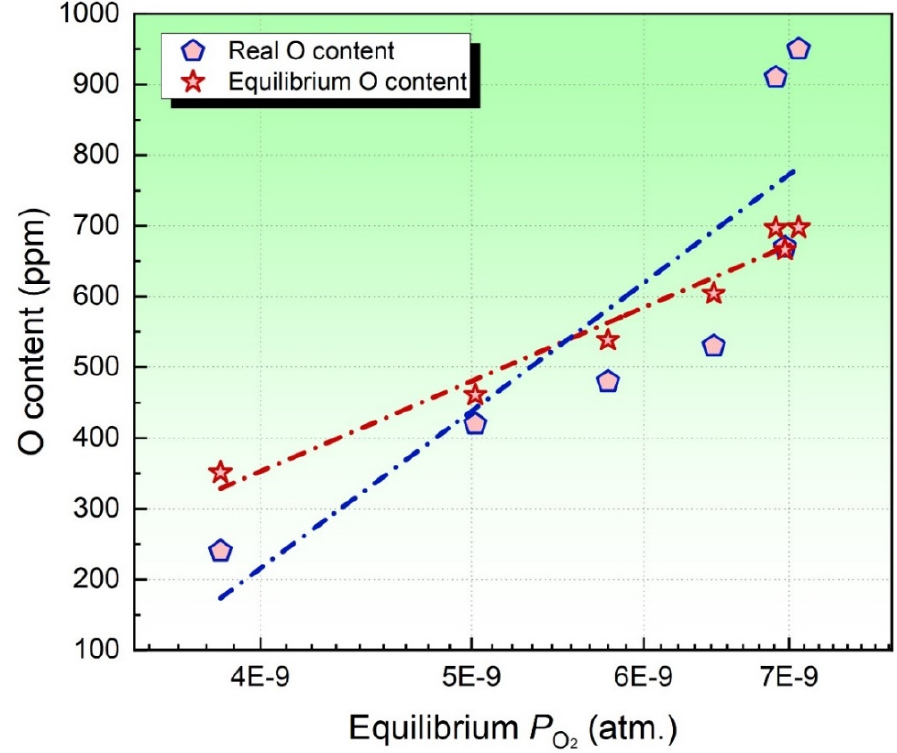
Figure 7. Relationship between equilibrium partial pressure of O 2 and oxygen content.